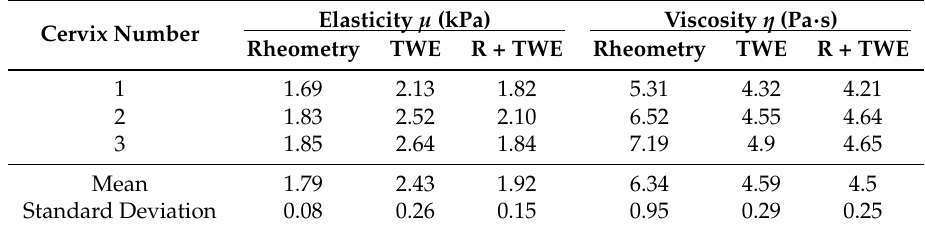
Table 2. Viscoelastic parameters using the data from rheometry, TWE, and a combination of the two methods for the Kelvin–Voigt model.